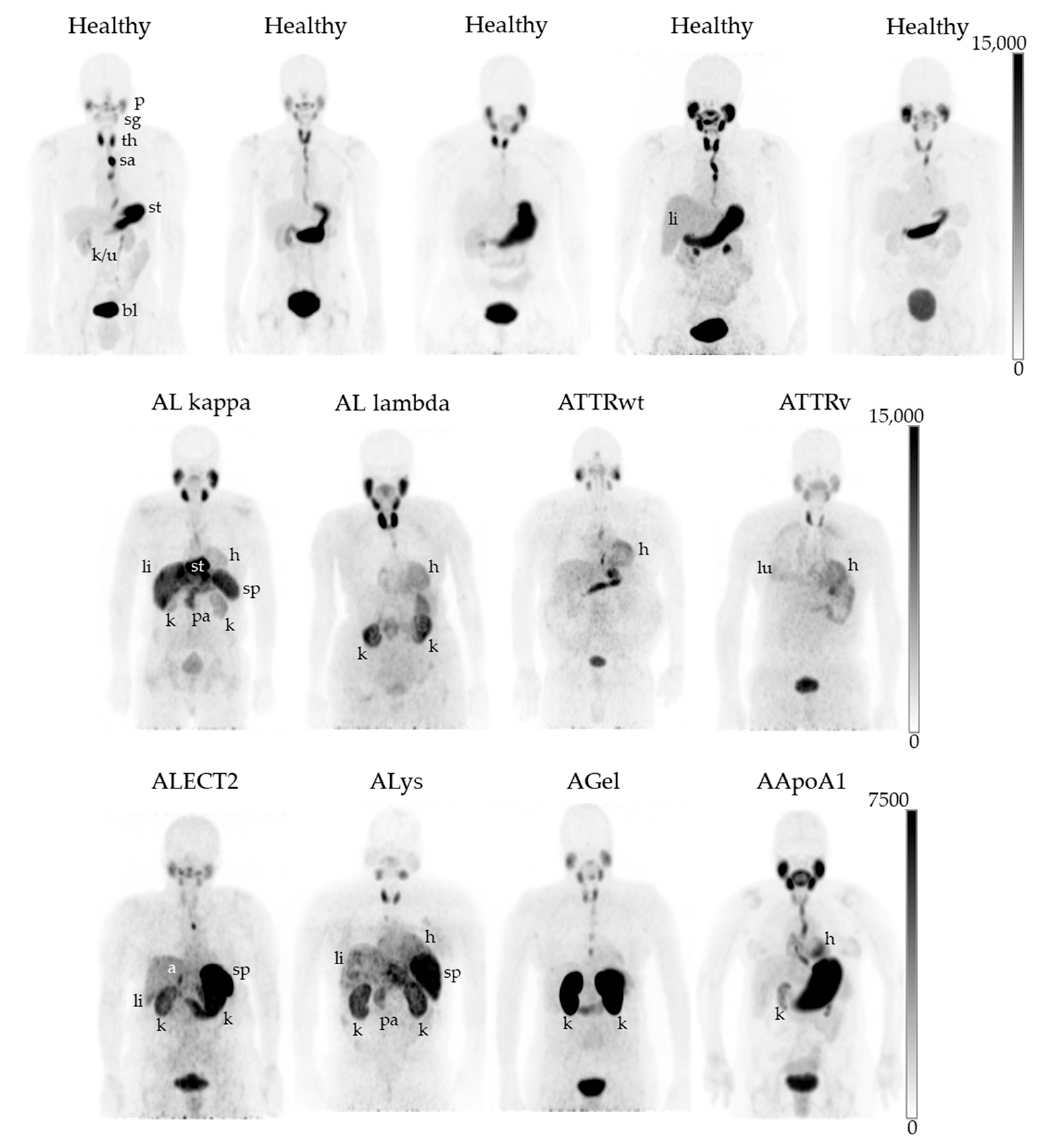
Figure 3. Biodistribution of 124 I-p5+14 in healthy subjects and patients with diverse types of systemic amyloidosis. Maximum intensity projection PET images of healthy subjects (healthy) and patients with amyloidosis (immunoglobulin light chain kappa and lambda (AL κ and AL λ ), transthyretin wild type and variant (ATTRwt and ATTRv), leukocyte chemotactic factor 2 (ALECT2), lysozyme (ALys), gelsolin (AGel), and apolipoprotein A1 (AApoA1)-associated amyloidoses). All subjects were administered 74 MBq (+/ − 10%) I-124, and images were scaled to a minimum and maximum of 0–15,000 Bq/cc, except for the ALECT2 patient, who received 38.5 MBq, where the image is scaled to 7500 Bq/cc. For clarity, due to its atypical location, the stomach of the AL kappa patient has been labeled but does not indicate amyloid uptake in this organ. P: parotid gland; sg: salivary gland; th: thyroid gland; sa: saliva; st: stomach; k/u: kidney/ureter; bl: urinary bladder; h: heart, li: liver; sp: spleen; k: kidney; pa: pancreas; lu: lung; a: adrenal gland.